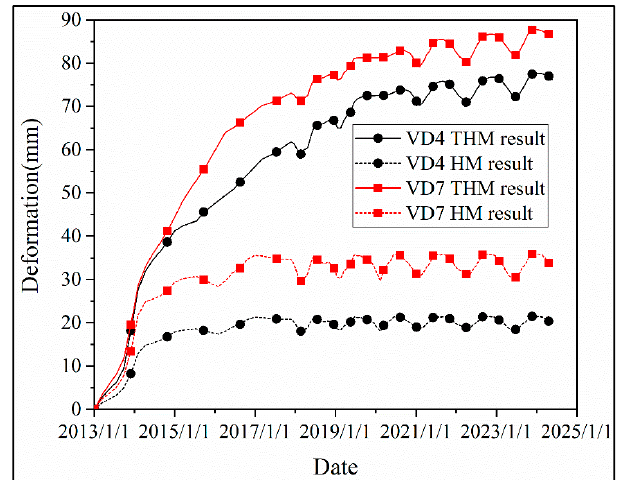
Figure 20. Comparison between thermal-hydro-mechanical (THM) simulated results and hydro- mechanical (HM) simulated results.